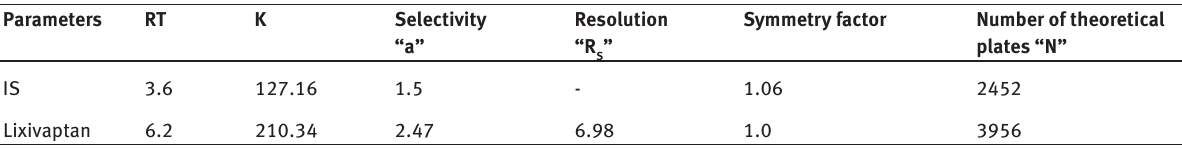
Table 2: Chromatographic system suitability parameters.